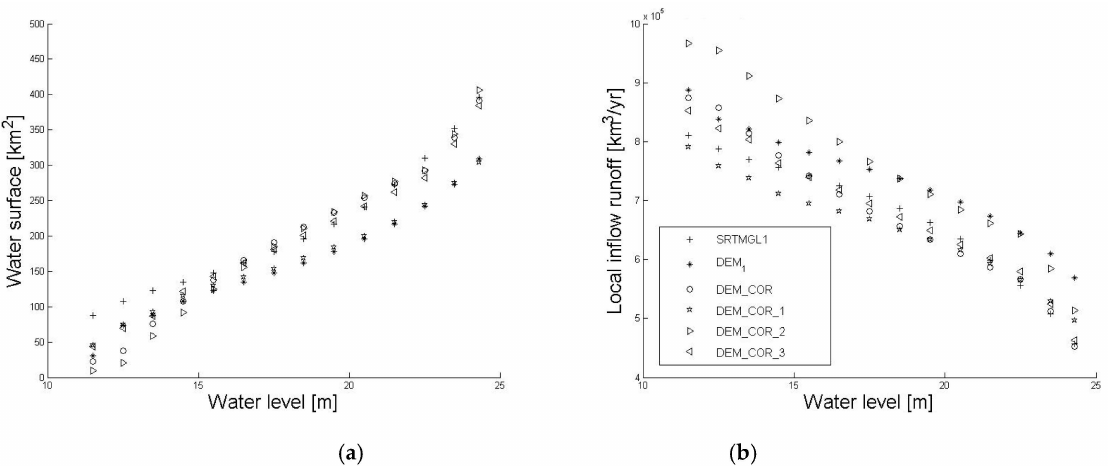
Figure 8. Comparison between different DEMs in terms of water surface and local inflow runoff. ( a ) Hypsometric curves of the Janauaca floodplain, ( b ) Dry areas in function of water